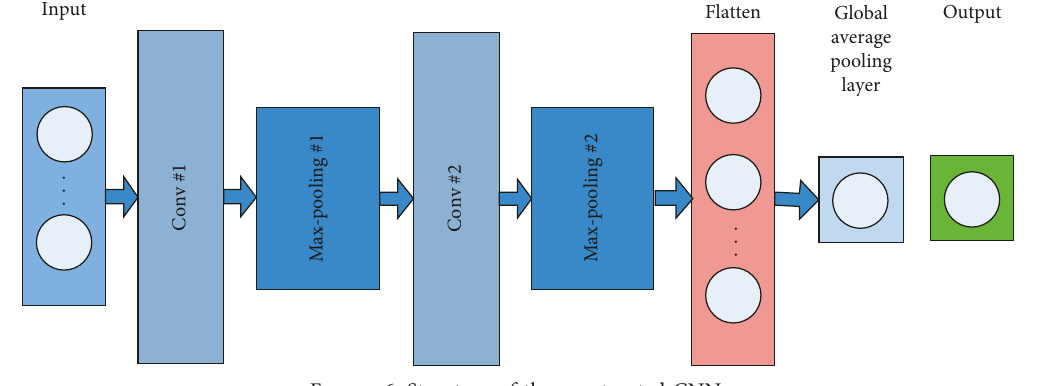
Figure 6: Structure of the constructed